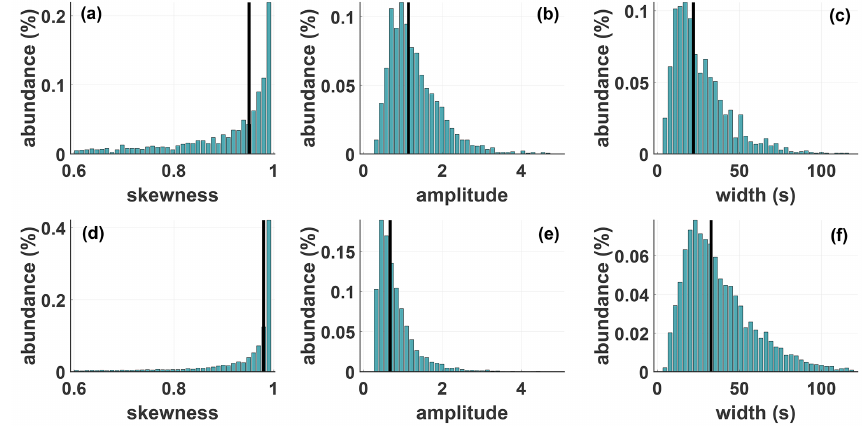
Figure 8. Distributions of skewness, amplitude and width for different levels of cometary activity. Panels (a) – (c) show the properties of steepened waves for low to intermediate activity from 1 March to 1 June 2015 ( Q ∼ 1 × 10 27 s − 1 ). For a strongly active comet from 15 August to 15 September 2015 ( Q ∼ 2 × 10 28 s − 1 ), the properties are shown in (d) – (f) . The abundance is normalized to the total number of observations in the respective interval. The black line marks the median of the respective distribution.